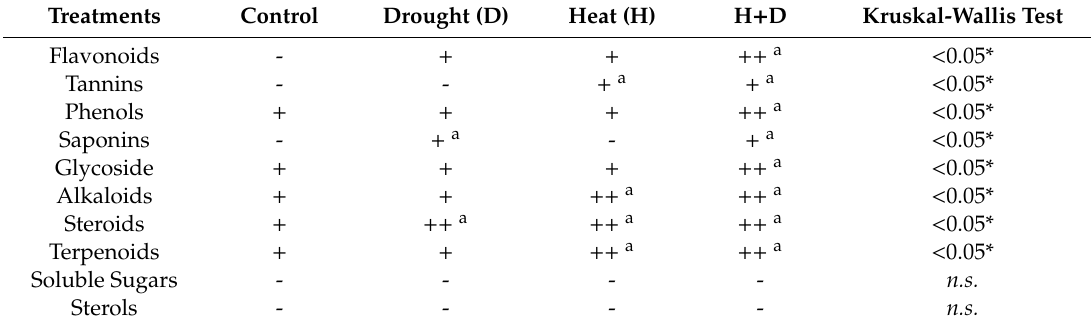
Table 1. E ff ect of drought, heat, and combined e ff ect of drought and heat stresses on estimated of phytochemicals in A. sieberi alba .